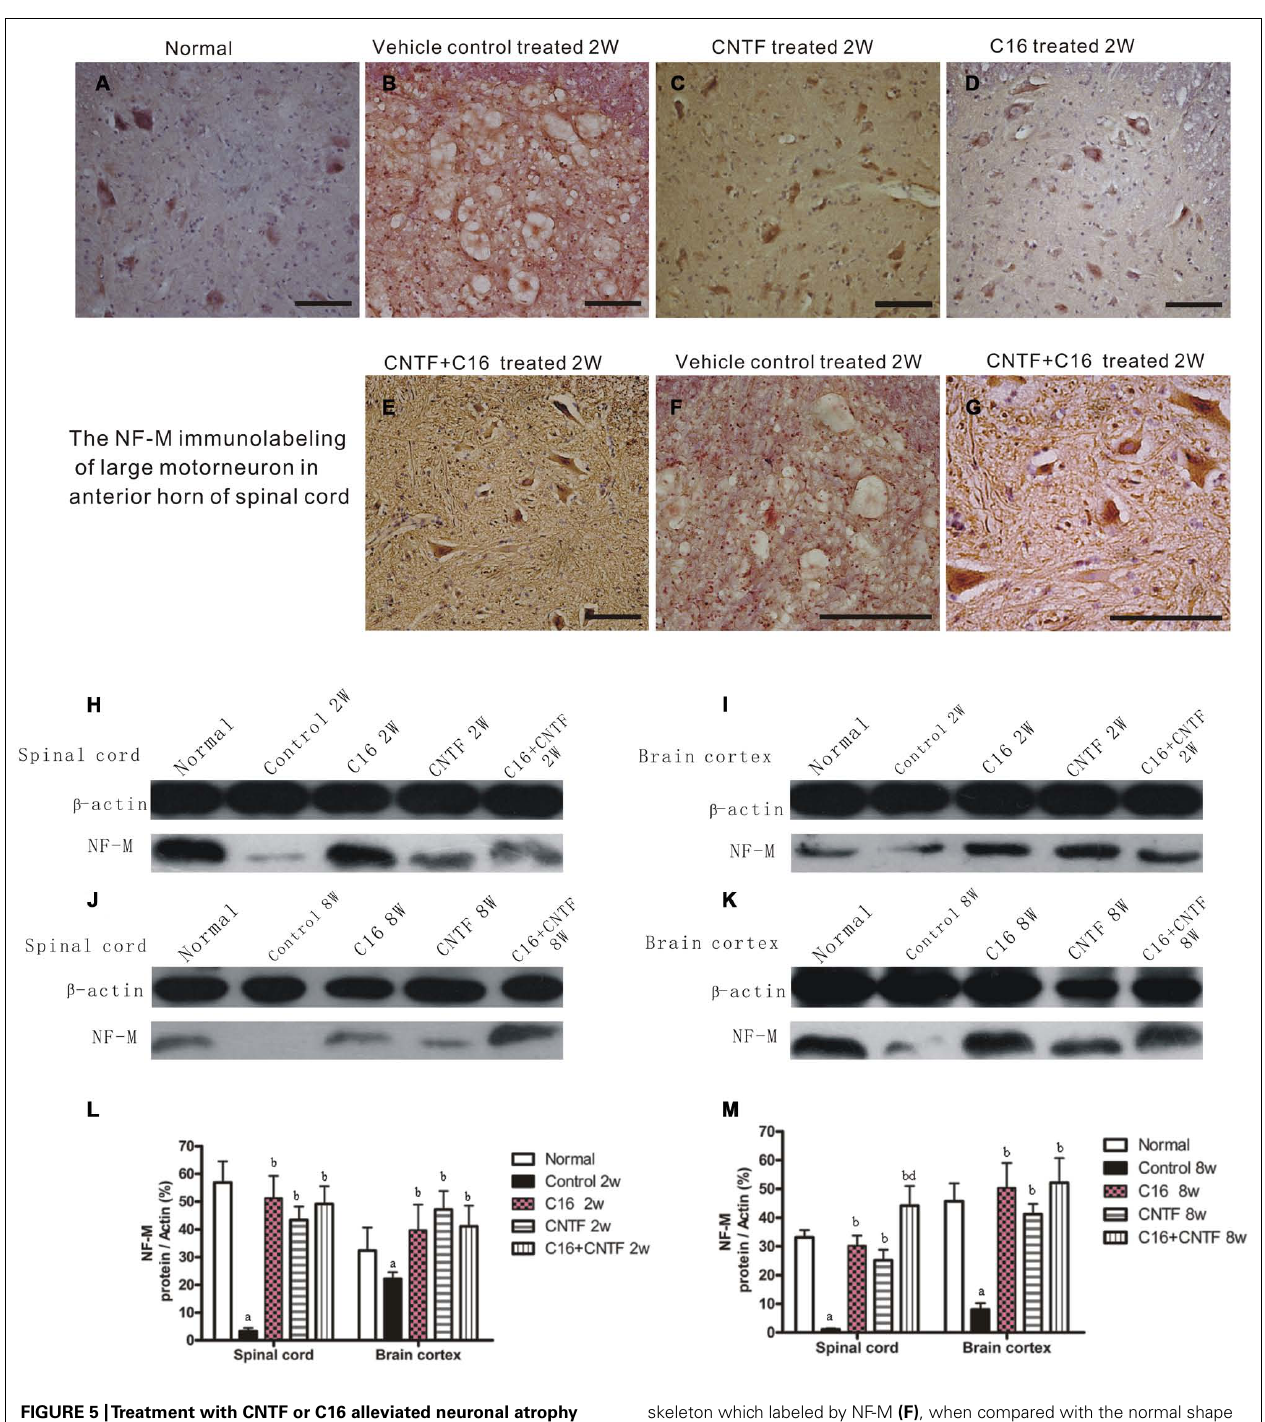
FIGURE 5 |Treatment with CNTF or C16 alleviated neuronal atrophy and axonal disruption at week 2 post-immunization. (A–G) NF-M immunostaining, counterstained with hematoxylin, traverse sections through anterior horn of lumbar spinal cord, bar = 100 μ m. (A) Normal control group. (B) Inflammatory infiltrates, neuronal atrophy, and dendrite and axonal disruption in vehicle-treated EAE rats. (C–E) Lots of perikaryal and axonal hyper-NF-M immunostaining motor neurons appeared in CNTF-treated (C) , C16-treated (D) , and C16 + CNTF-treated (E) EAE rats. (F,G) The enlarged image of vehicle-treated (F) and C16 + CNTF-treated (G) EAE rats.The motor neurons at the anterior horn of spinal cord lost the normal shape and